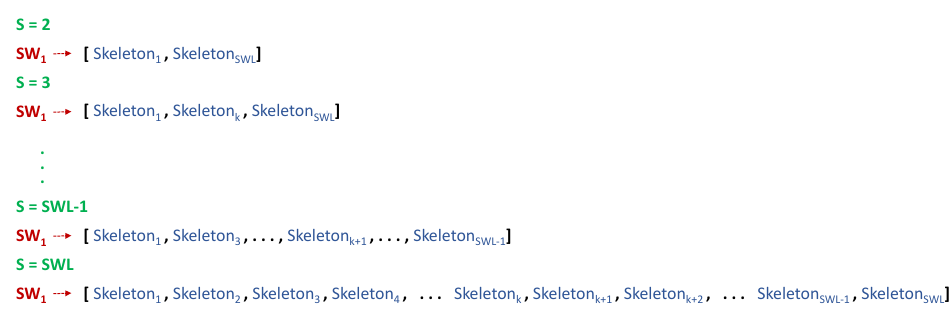
Figure 3. Selection of number of skeletons per